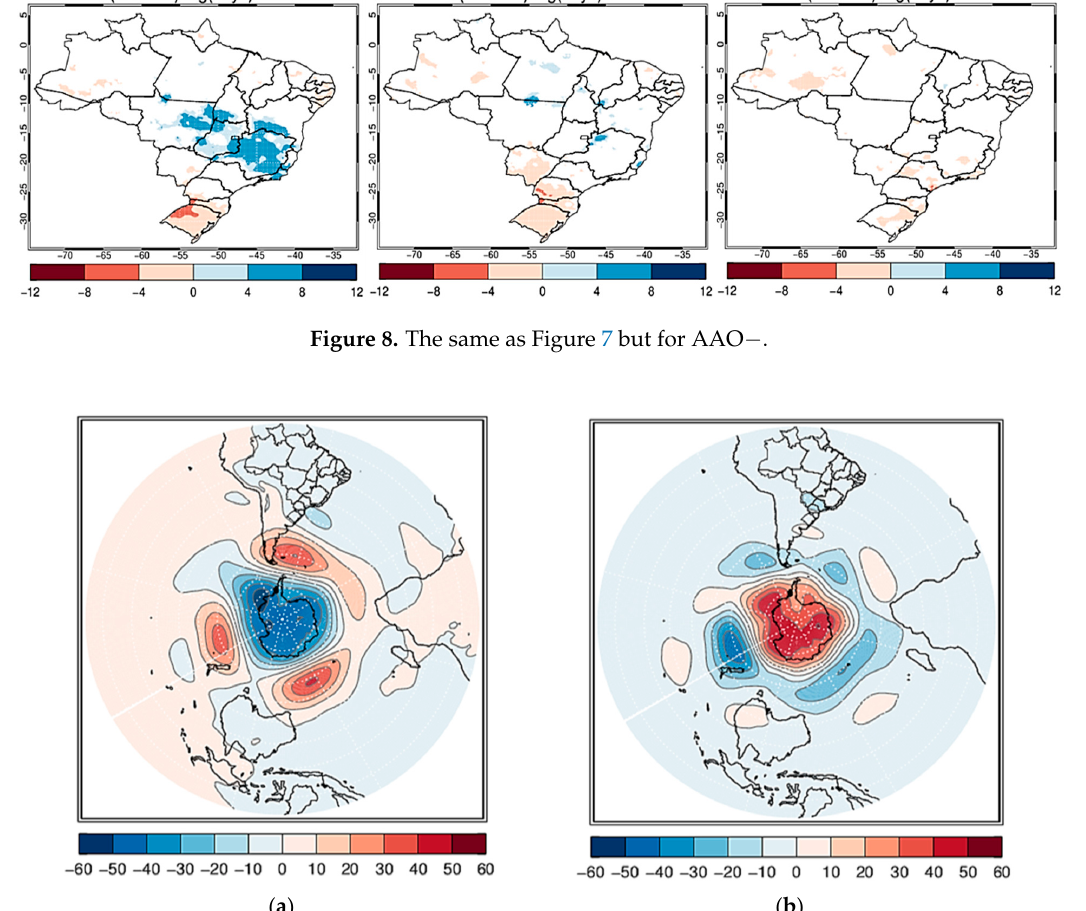
Figure 8. The same as Figure 7 but for AAO–.